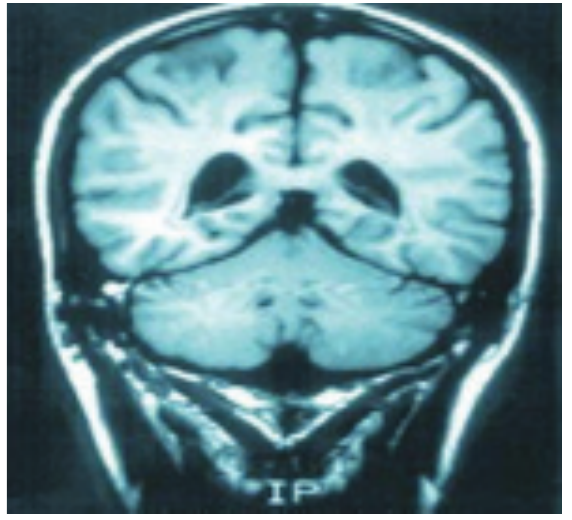
treatment(a) The brain CT image of an example patient before treatment Figure 2: Change in brain CT images before and after Table 1: Comparison of medication compliance of the two groups 6 months after discharge [(n, %), n = 90]